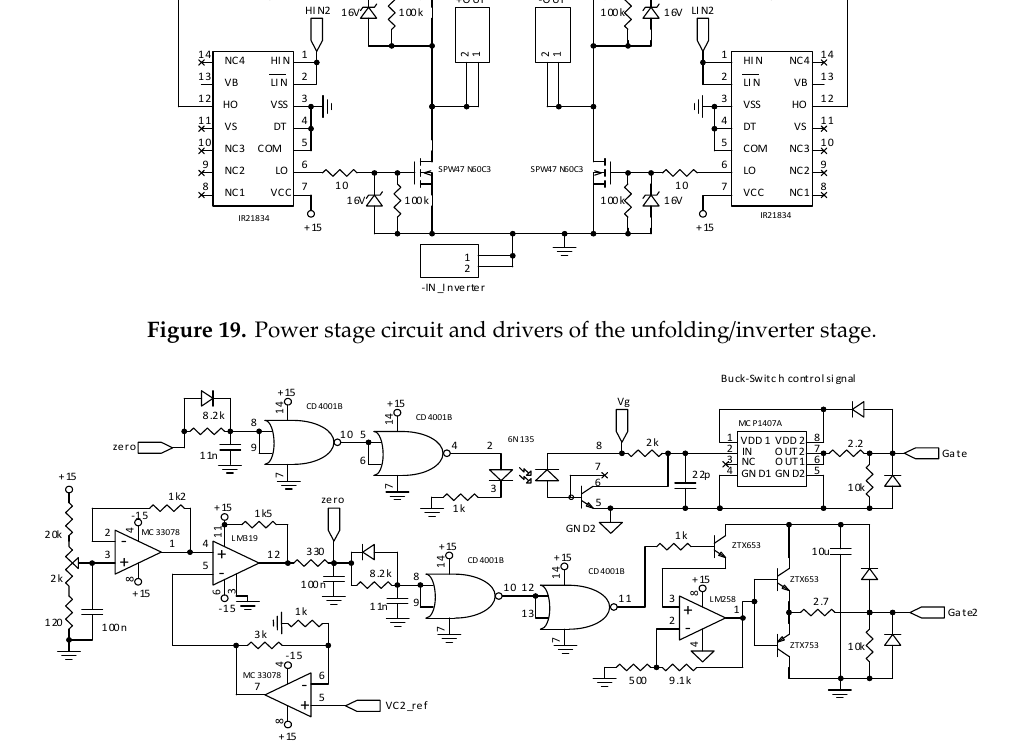
Figure 20. Zero-crossing detection circuit and Buck-switch control drivers.